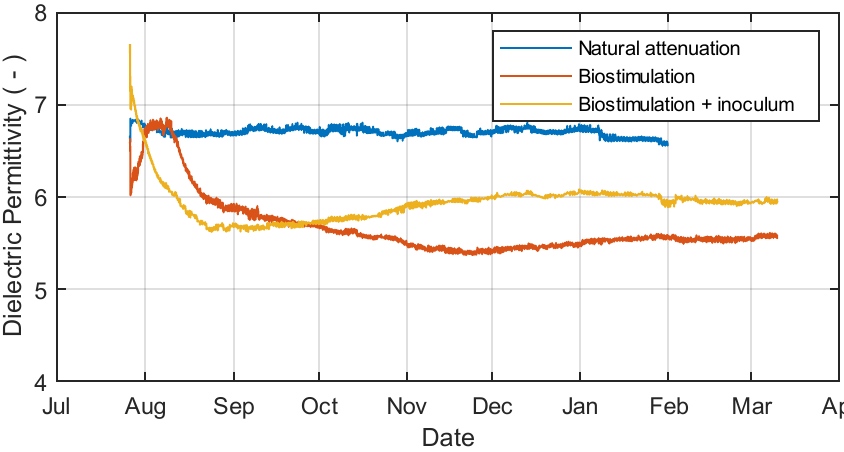
Figure 4. Electrical permittivity of the tested mesocosms.